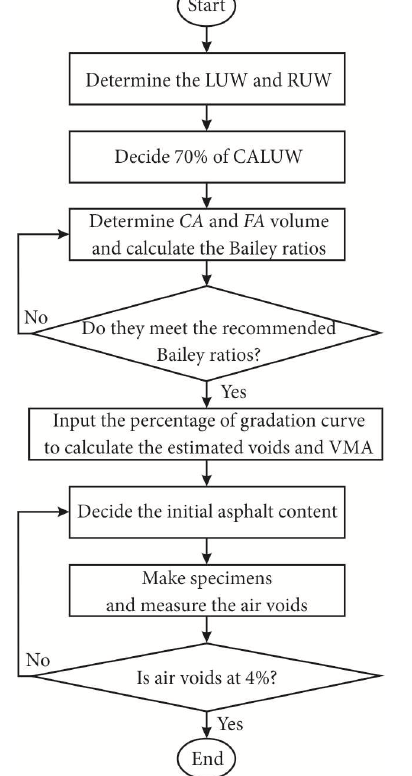
Fig. 1. The workflow of the experiment It is important to determine whether the changes in VMA of HND aggregates will follow the direction of Bailey principles. Thus, M1, the baseline blend was de signed with the lower limit of CA ratio with upper limit of FA ratios and lower limit of new CA ratio with upper limits of new FA ratios in a way that the mixture would have the lowest VMA in this study. The Bailey ratios for the subsequent mixtures were changed from M1. M2 and M3 had the same values of the CA ratio and FA ratios. The difference between the M1 and M2 was the change of new FA f ratio from 0.50 to 0.35. The difference between M1 and M2 was the change of the new CA ratio from 0.60 to 1.02 and the new FA f ratio from 0.50 to 0.35. The difference between M1 and M4 was the change of FA c ratio from 0.50 to 0.47. The difference between M1 and M5 was the change of FA c ratio from 0.50 to 0.39 and the new FA f ratio from 0.50 to 0.41. The difference between M1 and M6 was the change of CA ratio from 0.60 to 0.75. The difference between M1 and M7 was the CA ratio from 0.60 to 0.75 and new CA ratio from 0.60 to 1.01. The difference between M1 and M8 was the CA ratio of 0.60 to 0.75 and FA c ratio from 0.50 to 0.38. M9 and M10 were the blends with change of all ratios. M10 had the mid values of the six Bailey recommended limits. With this arrangement, the changes in VMA of each mixture could be seen